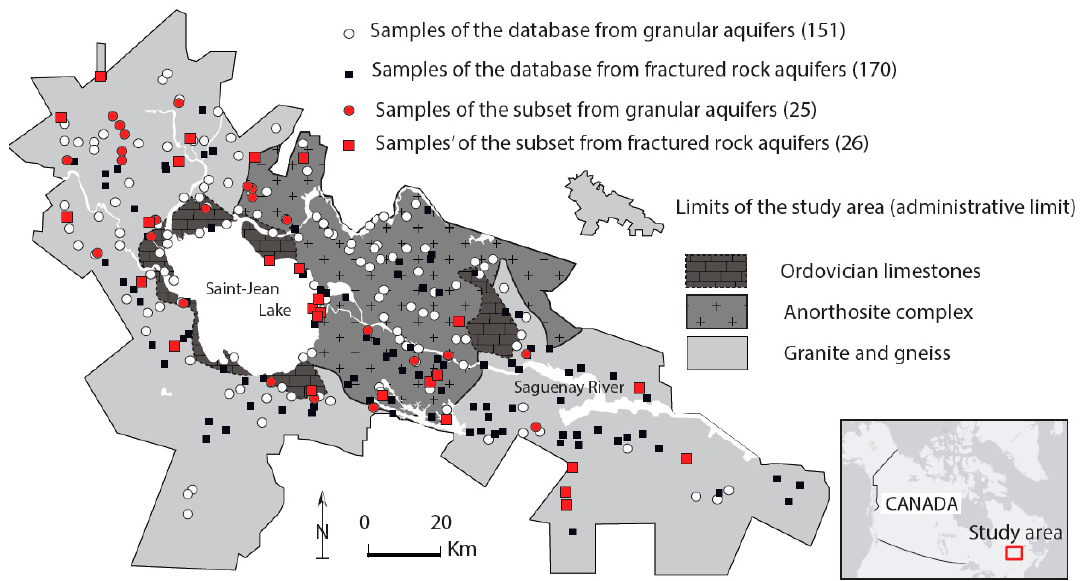
Figure 1. Location of the study area and the geographical distribution of all the samples (regional-scale database, 321 samples) collected within the limit of the study area. Samples from the subset (Section 4.2) selected from the regional-scale database are presented using red squares and red circles.